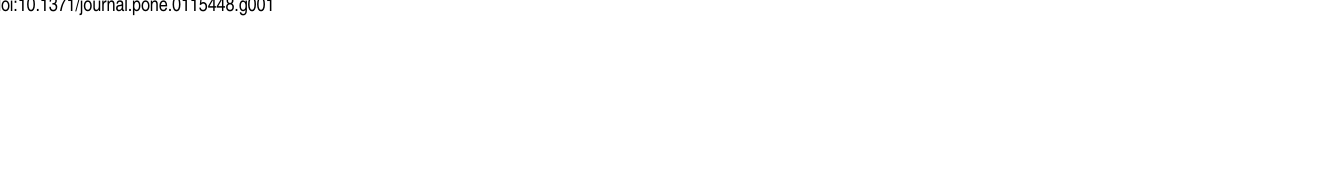
Fig. 1. Genome-wide miRNA expression in children with AD. A . Heatmap analysis showing miRNAs gene expression profile in serum samples in 8 children with AD and 8 healthy children. B . Heatmap analysis showing miRNAs gene expression profile in urine samples in 3 children with AD and 3 healthy children. C . Heatmap analysis showing significantly differentially expressed miRNAs in children with